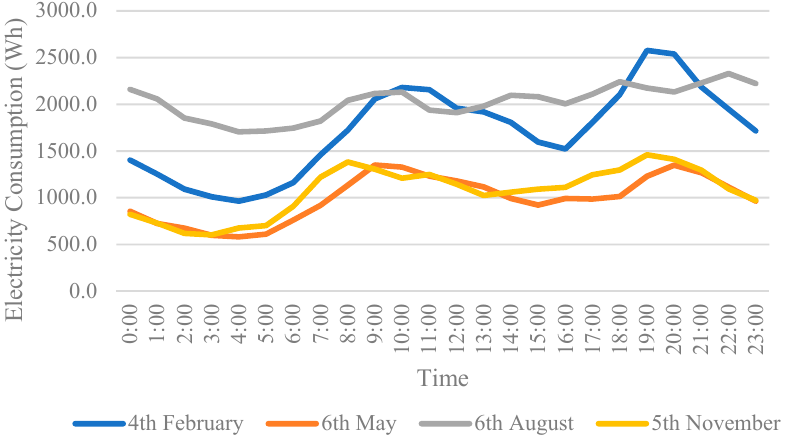
Figure 4. Comparison of the hourly average electricity consumption profiles for a medium- consumption household during the four